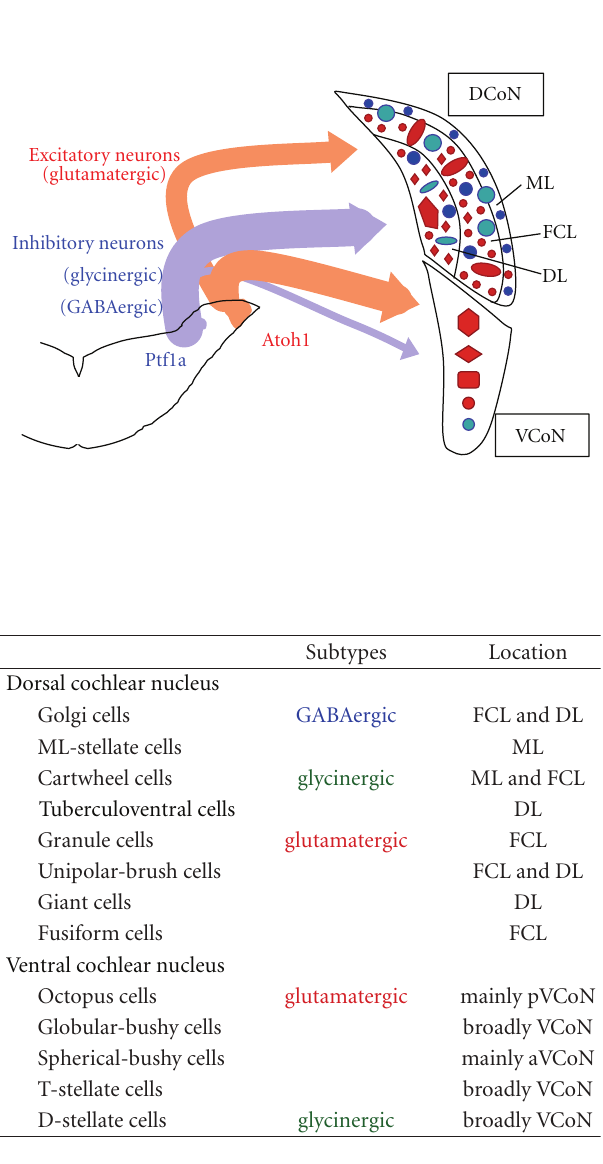
Figure 3: Lineages of excitatory and inhibitory neurons in the cochlear nucleus. (upper panel) Schematic of cochlear neuron lineages. Glutamatergic excitatory neurons are derived from the Atoh1-expressing RL whereas glycinergic/GABAergic inhibitory neurons are generated from Ptf1a-expressing neuroepithelial domain of the middle hindbrain (r2 ∼ 5). (lower panel) Various cochlear nucleus neurons characterized by neurotransmitter subtype and location. DCoN: dorsal cochlear nucleus; VCoN: ventral cochlear nucleus; aVCoN: anterior VCoN; pVCoN: posterior VCoN; FCL: fusiform cell layer; ML: molecular layer; DL: deep